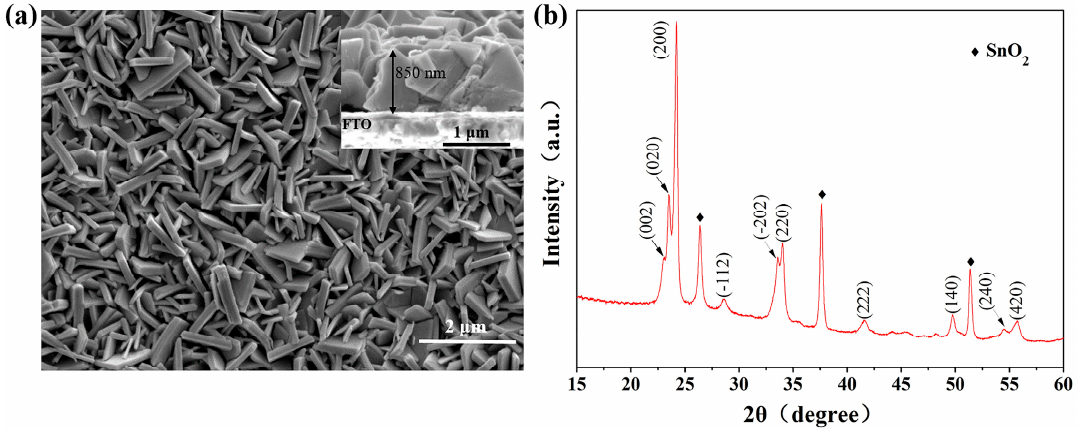
Figure 1. ( a ) The SEM images and ( b ) XRD patterns of the WO 3 nanoplate photoanode.